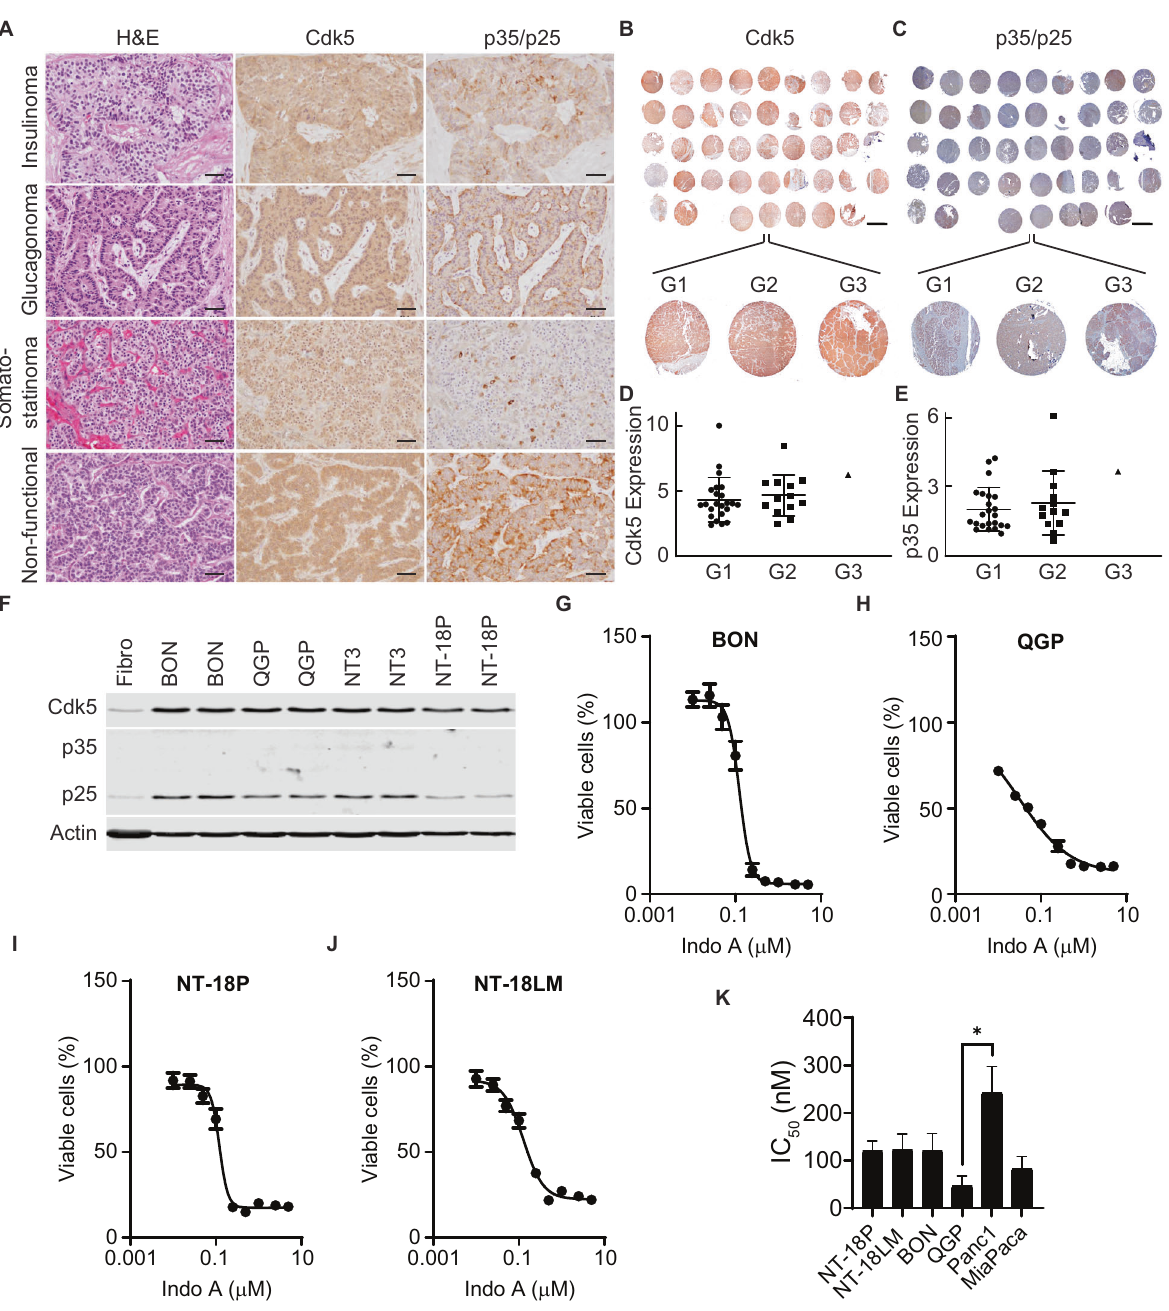
Fig. 1 Human PanNETs are dependent on Cdk5. A H&E stain and immunostains for Cdk5 and p35/p25 in G1 PanNETs. Scale bars = 50 μ m. Immunostains for Cdk5 ( B ) and p35/25 ( C ) from human PanNET TMA. Scale bar = 2 mm. Semi-quantitation of Cdk5 expression from B ( D ) and p35/25 expression from C ( E ) normalized to expression levels of each in a normal placenta core; column 1 row 4 of the TMA. Map of TMA in Supplementary Table S1. F Immunoblot of Cdk5 pathway components in fi broblasts and PanNET cells. G – J PanNET cell lines were treated with increasing concentrations of Indo A and monitored for effects on cell viability ( n = 3). K IC 50 values obtained from viability assays in G – J and Supplementary Fig. S1; ANOVA with Tukey ’ s multiple comparisons test for IC 50 values. All error bars represent